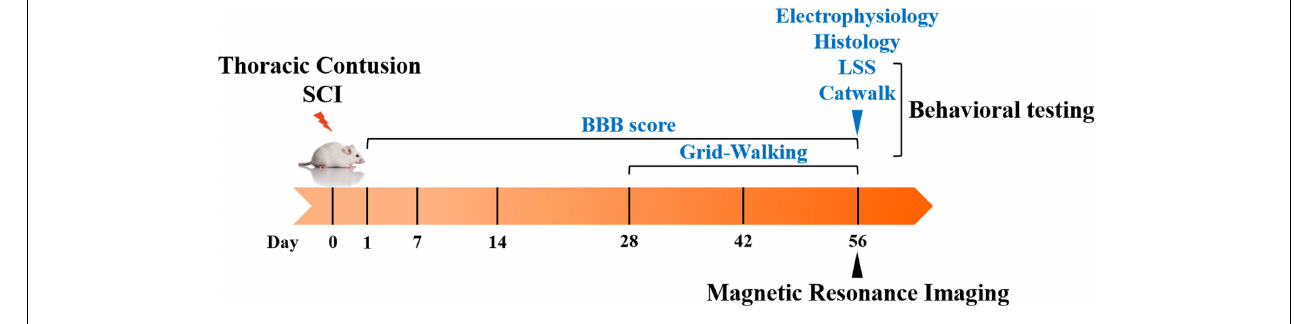
FIGURE 1 | Schematic diagram of the experimental design.